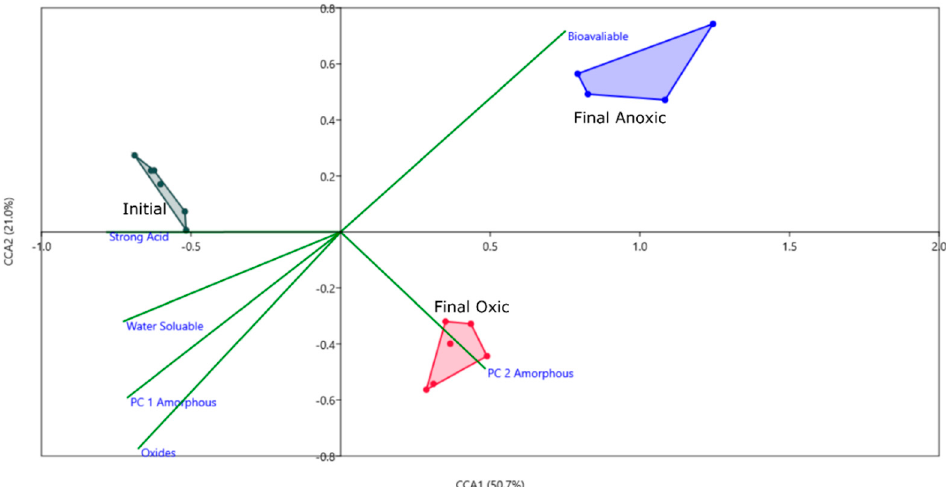
Figure 5. CCA plot using PCA components as environmental variables for each geochemical phase. PC 1 and PC 2 are included for the oxyhydroxide mineral phase as they are both significant, and only PC 1 is included for all other phases. Axis one represents 50% of the variance and axis 2 represents 21%. Convex hulls are connecting sample groups on the figure, done within PAST.